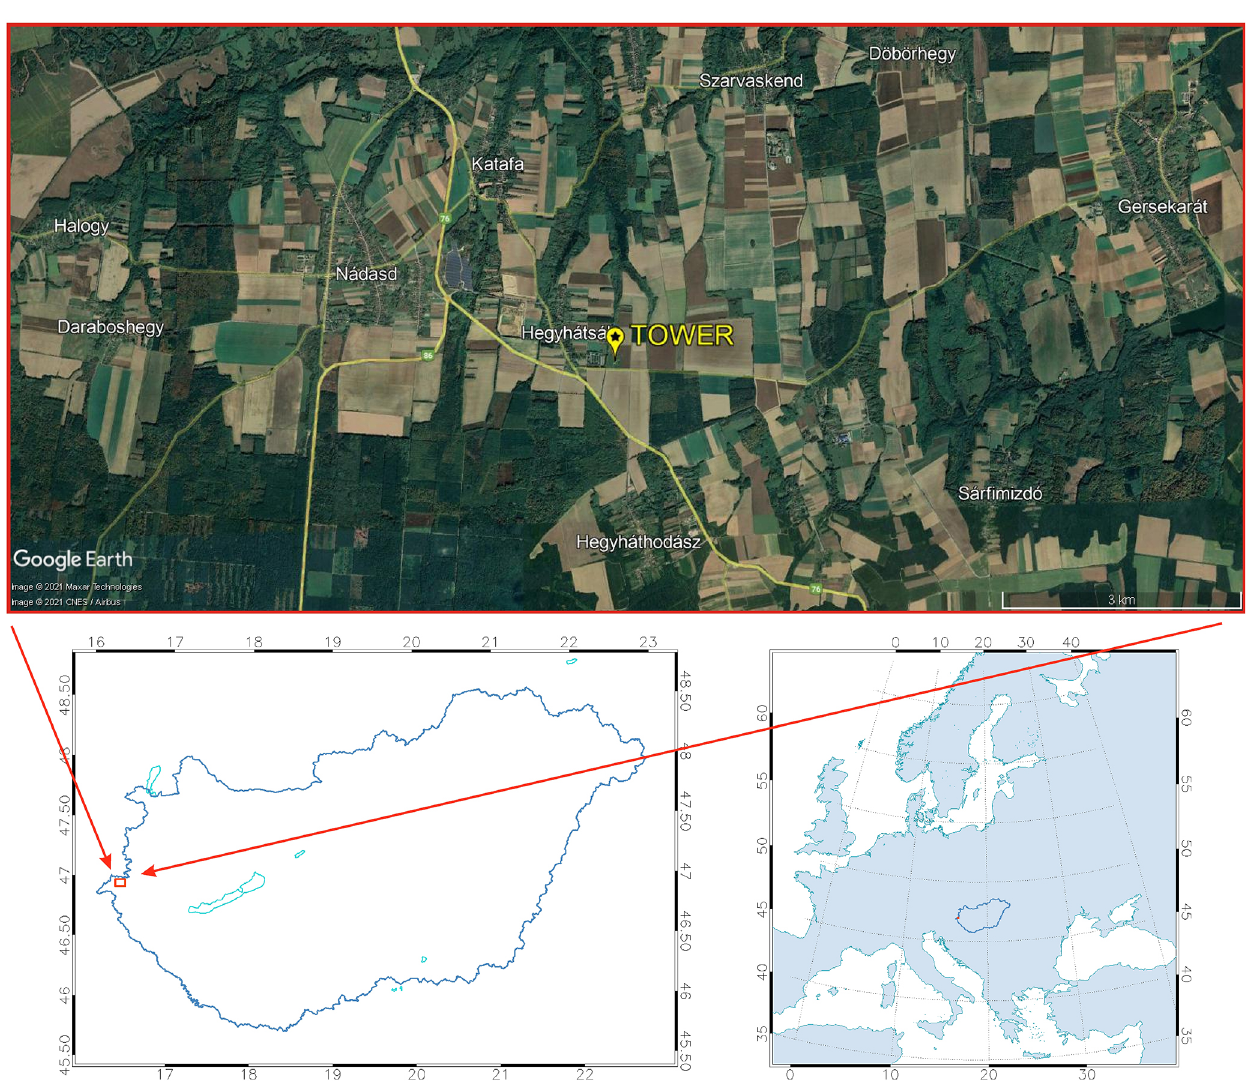
Figure 1. Location and surrounding region of the Hegyhátsál tall-tower GHG monitoring site on a Google Earth satellite image. © Google